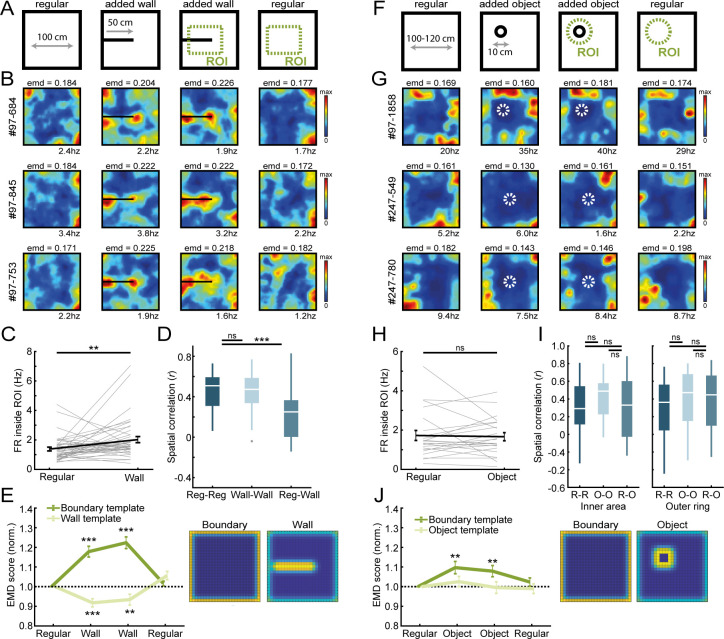
Border cells respond to new walls but not to the addition of new objects.(A) An additional temporary wall was placed on the maze in the middle sessions. (B) Spatial rate maps of three typical border cells across regular and added wall sessions during one recording day. (C) Border cells formed new firing fields nearby the added wall, as cells significantly increased their firing rate in the region-of-interest (ROI) area around the central wall. (D) Spatial correlations between rate maps of regular and wall sessions were decreased but remained high within session type. (E) Dissimilarity increased for the boundary template as cells formed fields around the added wall, whereas dissimilarity decreased for an added wall template. (F) A new object was introduced either in the north-west corner or the center of the maze. (G) Spatial rate maps of three example border cells across regular and object sessions. (H) Firing rate of border cells in a ROI around the added object remained unchanged between session types. (I) No significant drop was observed in spatial correlations of border cells by the addition of the object. Correlations were split between an outer ring (four rows) and the remaining inner area to isolate activity related to the outer walls versus the object. (J) There was an increase in EMD scores for the boundary template, whereas the spatial rate maps did not fit with the object template either, as their EMD scores remained unchanged. **p<0.01, ***p<0.001, Wilcoxon signed-rank test.